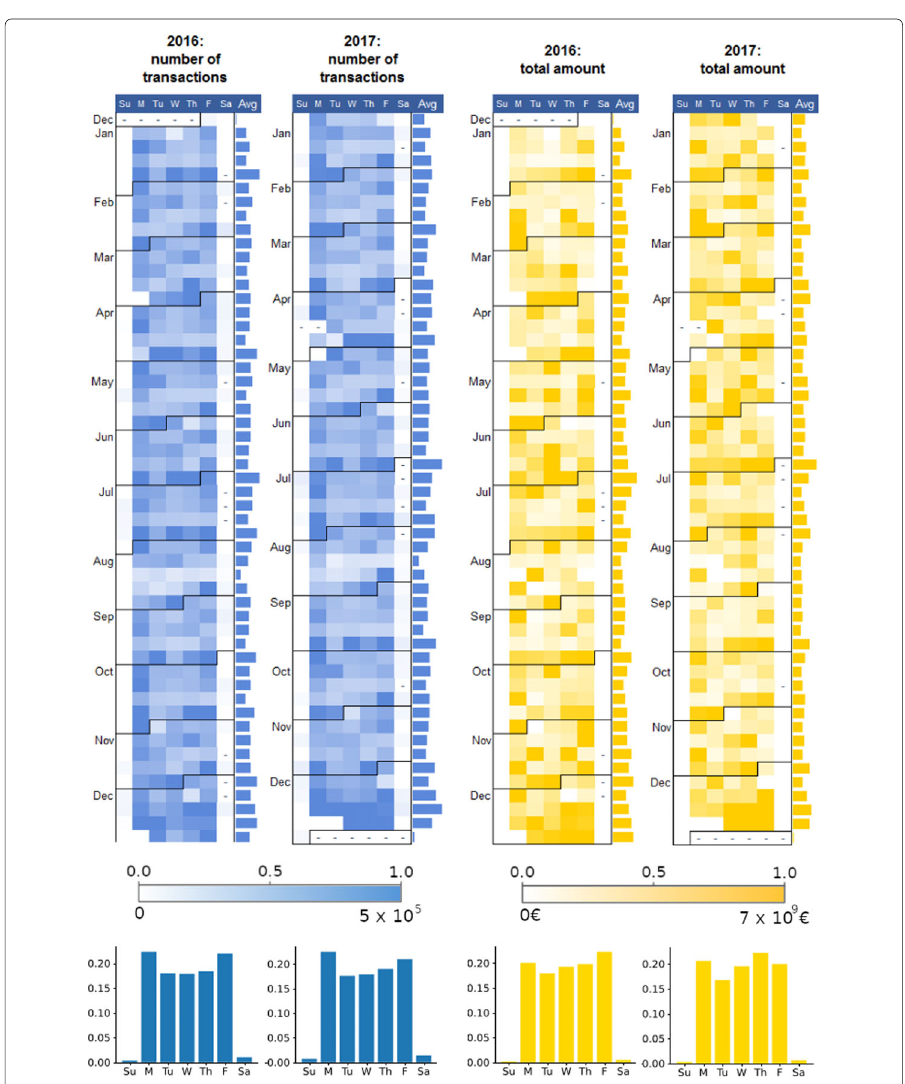
Fig. 4 Calendar maps: we show how the total daily number (blue) and amount (yellow) of transactions change between 2016 (first and third column) and 2017 (second and fourth column). We can see that there is an increment, both in number of transactions and total amount, in the last days of each month (likely due to the salaries payments) and in particular in June and December (likely because of bonus salaries and